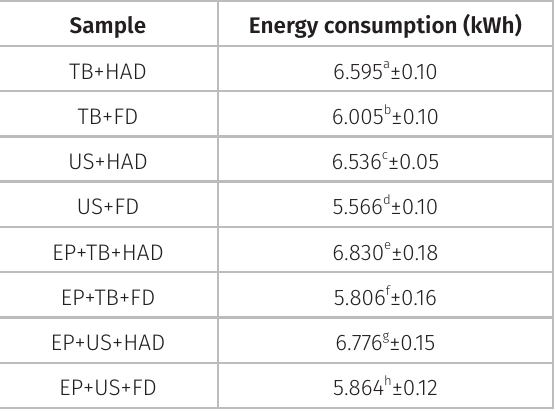
Table III. Energy consumption for processing